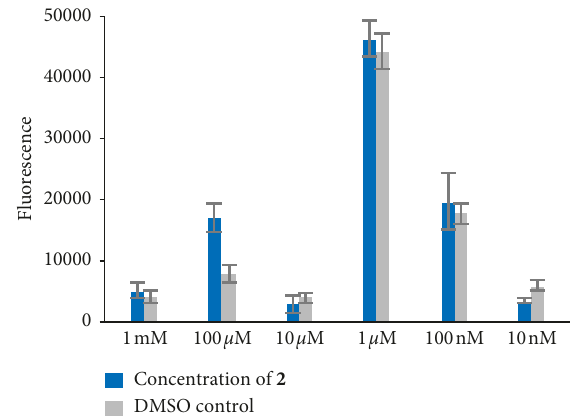
Figure 5: Viability of human epithelial cells is unaffected by 2 . Cells were exposed to 2 at different concentrations up to 1 mM for 24h. Viability, which is correlated with fluorescence, was quantified using the CellTiter-Blue assay. Data presented are mean fluo- rescence ± SEM ( n � 3–5 for each